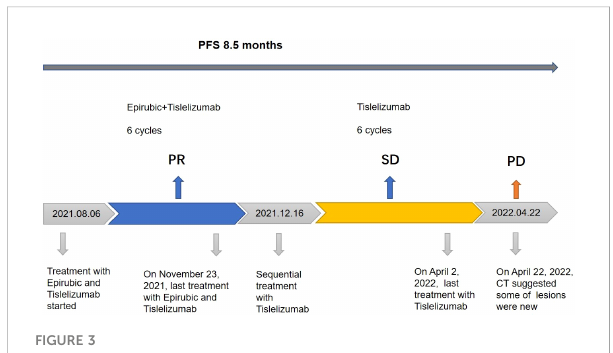
FIGURE 3 Review of treatment process. Treatment process and effect evaluation of the patient. PFS, progression-free survival; PR, partial response; SD, stable disease; PD, progressive disease.